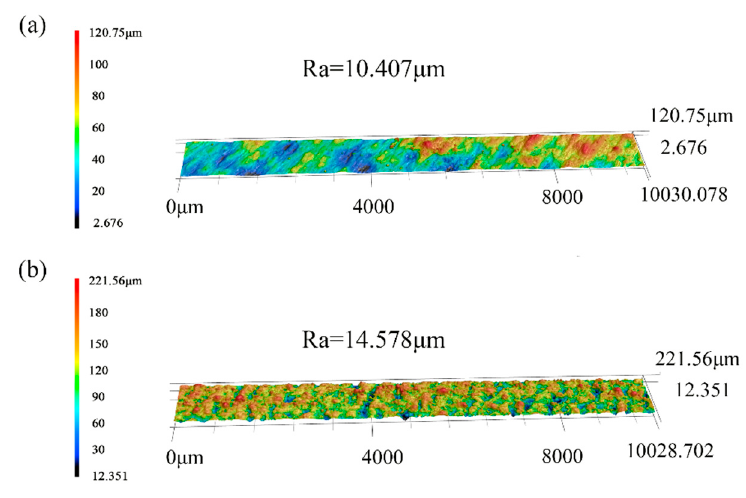
Figure 5. The surface quality of the ( a ) top and ( b ) side face of the as-built